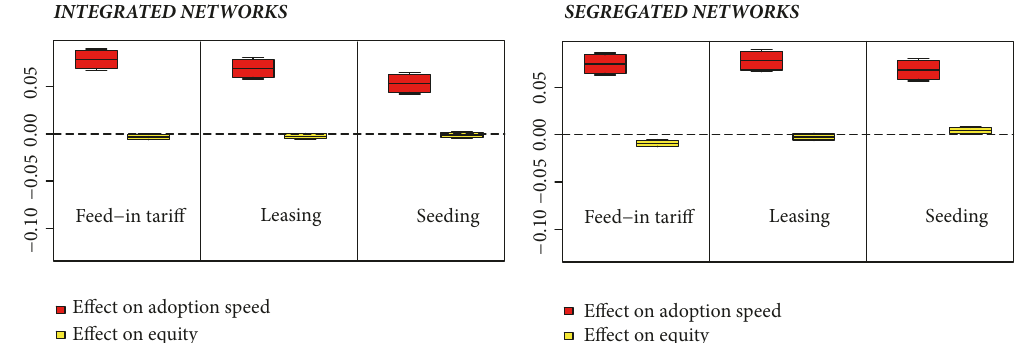
Figure 4: Graphical depiction of program outcomes, speed of adoption versus equity in segregated versus integrated